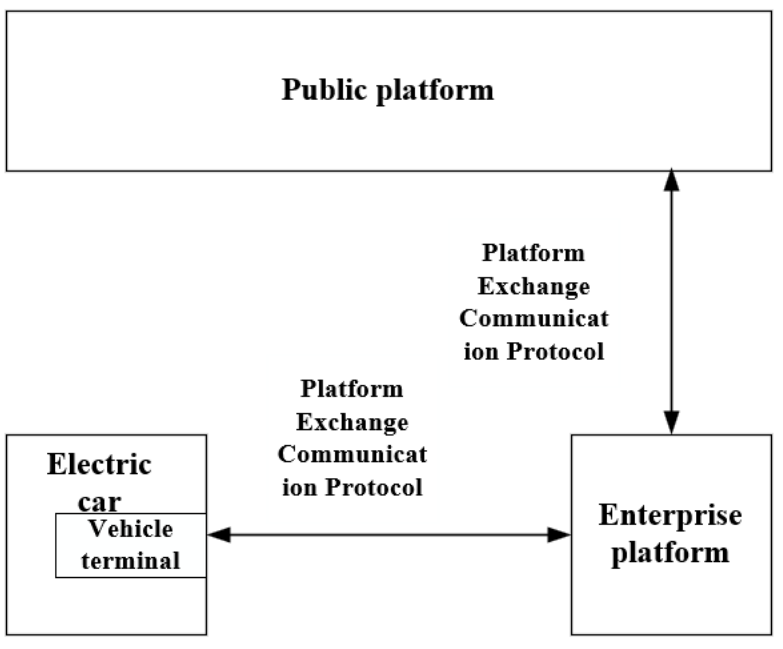
Figure 3. Structure of electric vehicle remote service and management